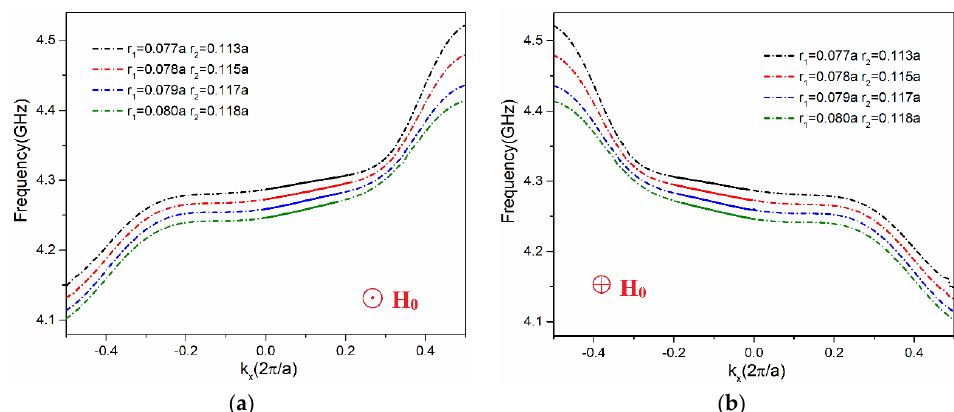
Figure 4. Dispersion curves of the edge modes for parameters 𝑟 1 = 0.077𝑎 , 𝑟 2 = 0.113𝑎 ; 𝑟 1 = 0.078𝑎 , 𝑟 2 = 0.115𝑎 ; 𝑟 1 = 0.079𝑎 , 𝑟 2 = 0.117𝑎 ; and 𝑟 1 = 0.08𝑎 , 𝑟 2 = 0.118𝑎 . under the ( a ) +𝑧 and ( b ) –𝑧 direction applied magnetic field, The thick solid lines represent the flat band region for slow light. ⊙ and ⊕ indicate +𝑧 and –𝑧 direction externally applied magnetic field, respectively.